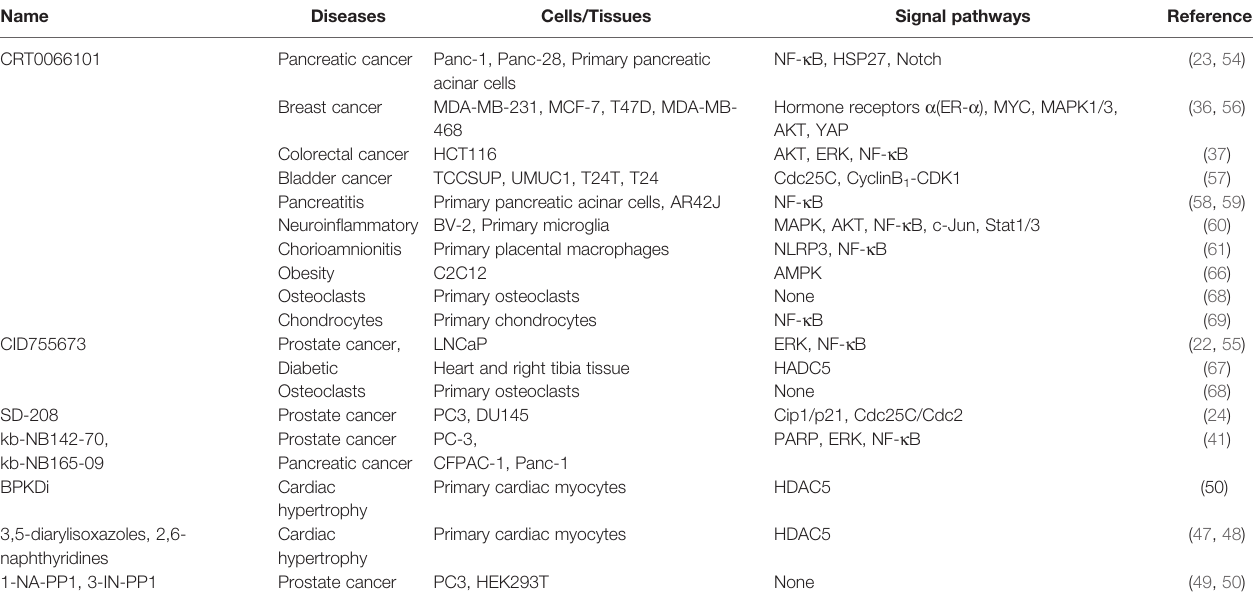
TABLE 1 | Inhibition of PKD by various small molecular